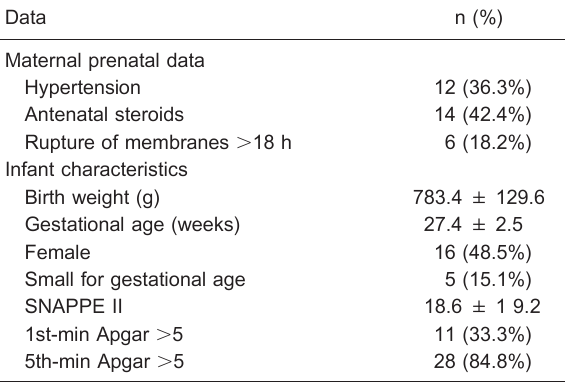
Table 1. Maternal prenatal data and characteristics of the 33 infants enrolled for continuous positive airway pressure installed prophylactically in the delivery room.